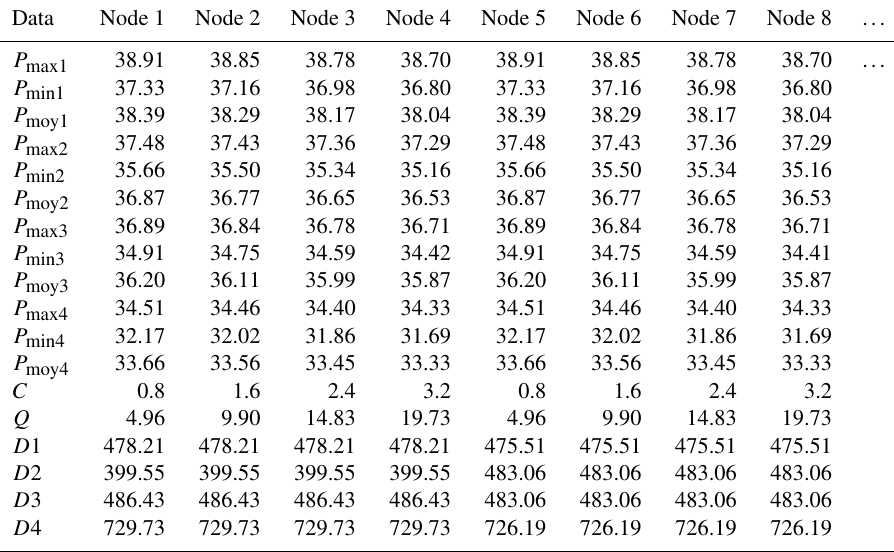
Table 2. Result of model leak simulations.